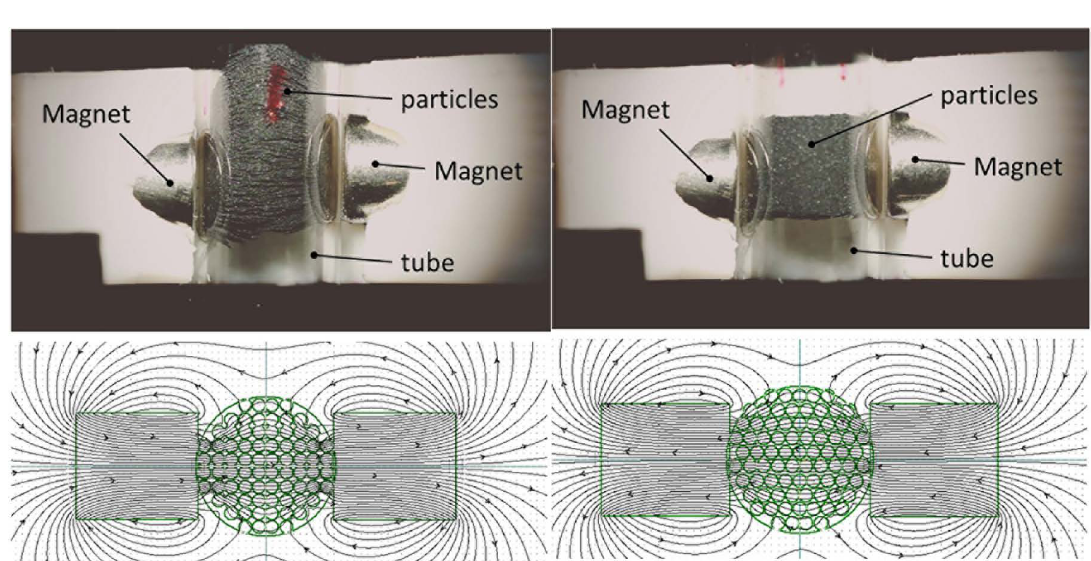
Figure 2. Particles in a tube at initial position (left) holding by permanent magnets with vizimag simulation of particles array structure and particles in a tube after rotation of permanent magnets (right) with a vizimag simulation of particles array